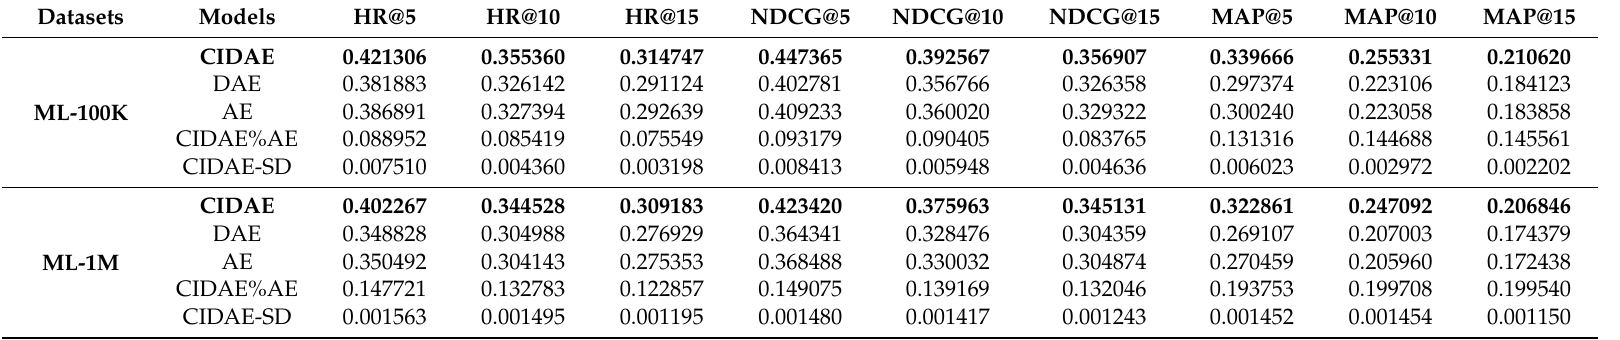
Table 2. Performance comparison of CIDAE, DAE, and AE based on HR@N, NDCG@N, and MAP@N. (N = 5, 10,